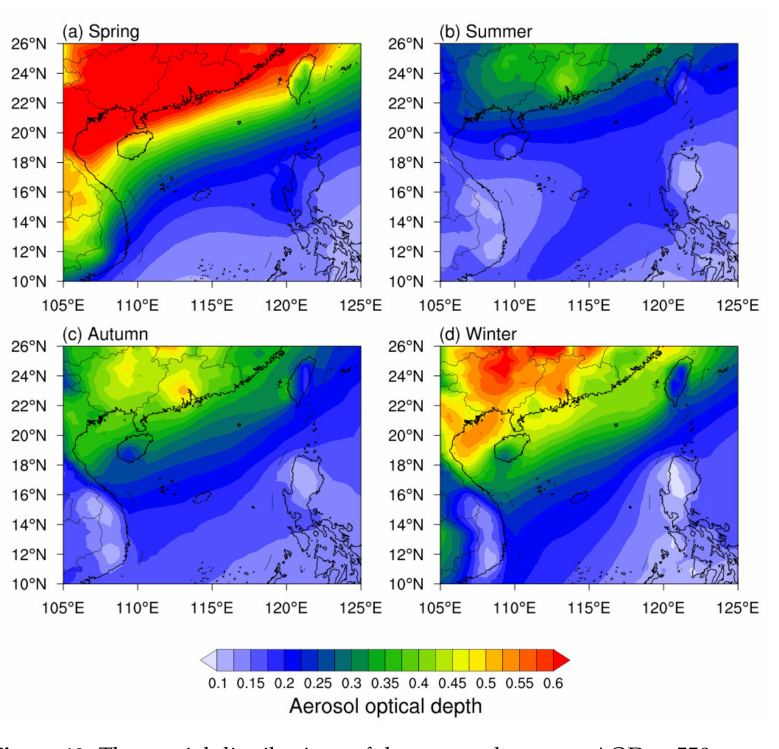
Figure 13. The spatial distributions of the seasonal average AOD at 550 nm over the study region using the long-term MERRA-2 atmospheric products from 2012 to 2021.